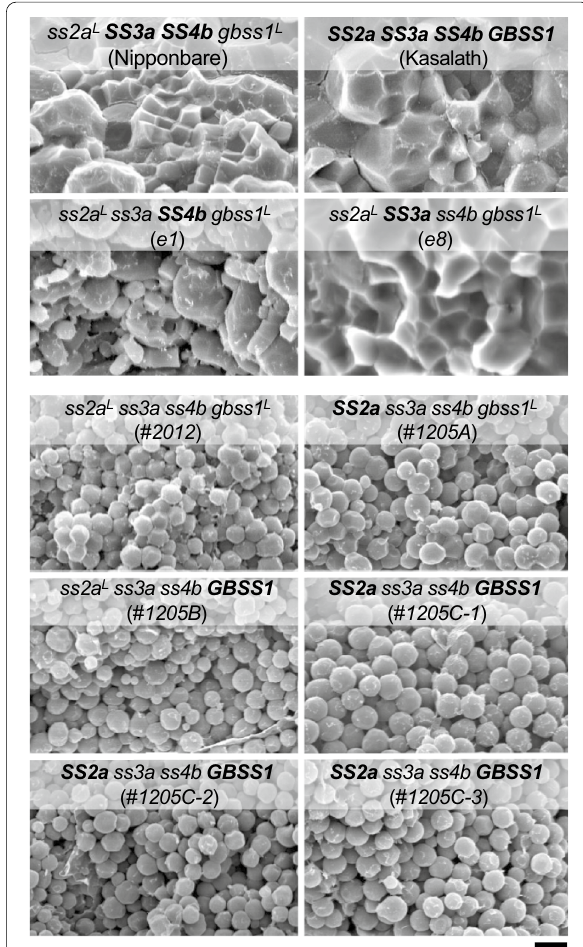
Fig. 4 Scanning electron micrographs of the cross-sections of mature seeds. Scale bar